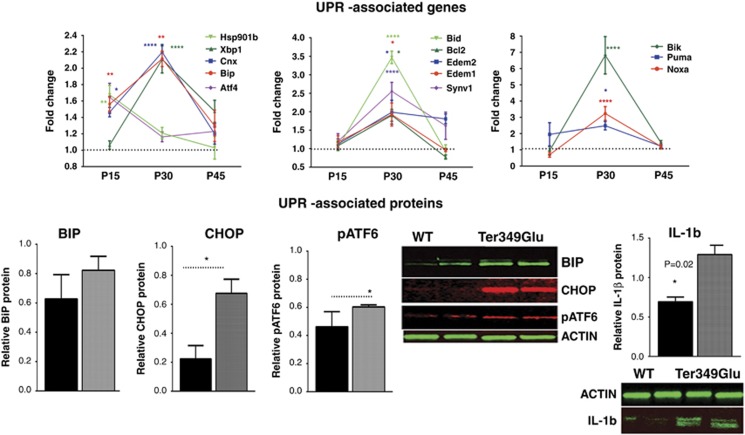
An activated UPR was found in ADRP retinas expressing a class I Ter349Glu
RHO mutant (N=4). The distribution of data
values is shown in S.E.M. Upper panel: expression of UPR-associated genes
was elevated in Ter349Glu RHO retinas during ADRP progression as
measured by qRT-PCR. Mainly, overexpression of UPR-associated genes was
detected at P30 (*P<0.05, **P<0.01,
***P<0.001 and
****P<0. 0001). Bottom panel: western blot
analysis revealed activation of UPR markers CHOP and pATF6
(P=0.020 for both) (N=4). Images of the
western blots are shown on the side. In addition, the inflammatory marker
IL-1β was found to be increased by 1.9-fold in P30
Ter349Glu retinas (P=0.020)